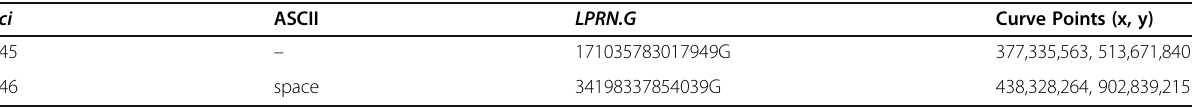
Table 2 Reference table in proposed hash function (Continued) ci ASCII LPRN.G